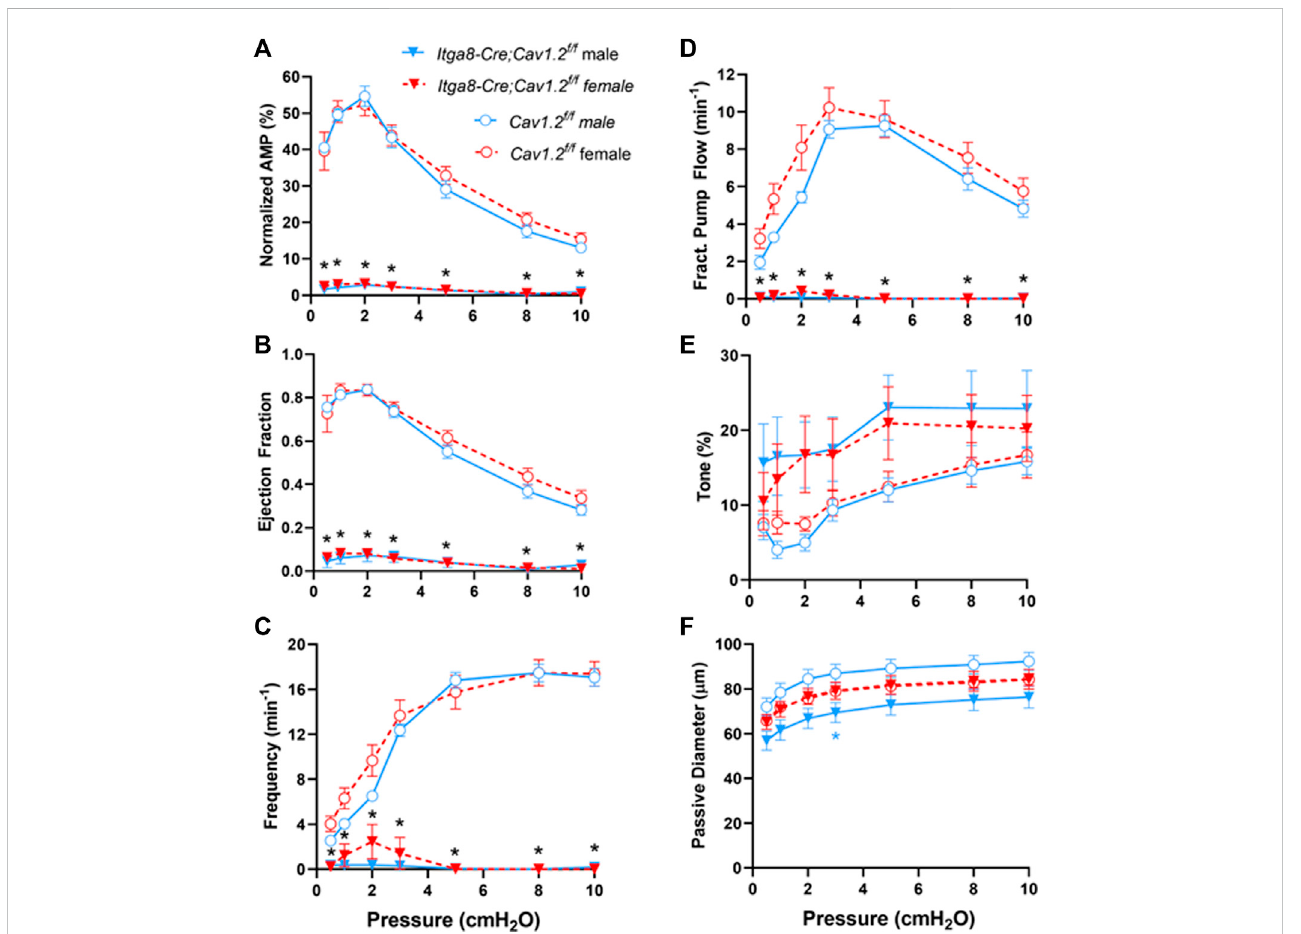
FIGURE 4 Summary of contractile parameters, (A) Normalized Amp, (B) EF, (C) Frequency, (D) FPF, (E) Tone, (F) Passive Diameter, for popliteal lymphatic vessels from Cav1.2 f/f mice and Itga8-CreER T2 ;Cav1.2 f/f mice at various pressures from 0.5 to 10 cmH 2 O. The parameters and statistical tests were determined as described in Methods. Black asterisks indicate signi fi cant differences inparameters both between10 male Cav1.2 f/f and 8 male Itga8-CreER T2 ;Cav1.2 f/f vessels andbetween10female Cav1.2 f/f and9female Itga8-CreER T2 ;Cav1.2 f/f vessels ( p < 0.05).Blueasterisksindicatesigni fi cantdifferencesbetweenonlymale Cav1.2 f/f and male Itga8-CreER T2 ;Cav1.2 f/f parameters ( p <